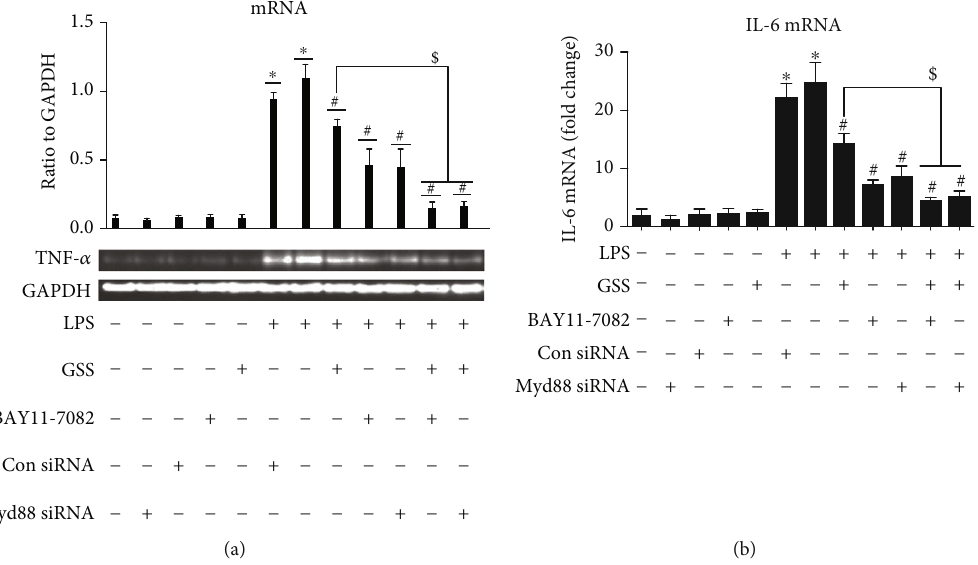
Figure 7: GSS inhibit LPS-induced IL-6 expression in ECs via Myd88/NF- κ B signaling pathway. (a) After transfection with Myd88 siRNA for 48 hours, ECs were treated with GSS for another 2 hours prior to the stimulation of LPS; the expression of IL-6 was determined by RT-PCR. Similarly, ECs were pretreated with BAY11-7082 (10 μ mol/l) and GSS for 2 hours and then incubated with LPS; the IL-6 expression was checked by RT-PCR. (b) The RT-qPCR results of IL-6 was presented as a histogram. The relative amount was normalized to the housekeeping gene GAPDH. ∗ P < 0 : 05 versus negative control. # P < 0 : 05 versus the corresponding LPS treatment group. $ P < 0 : 05 versus the corresponding GSS treatment